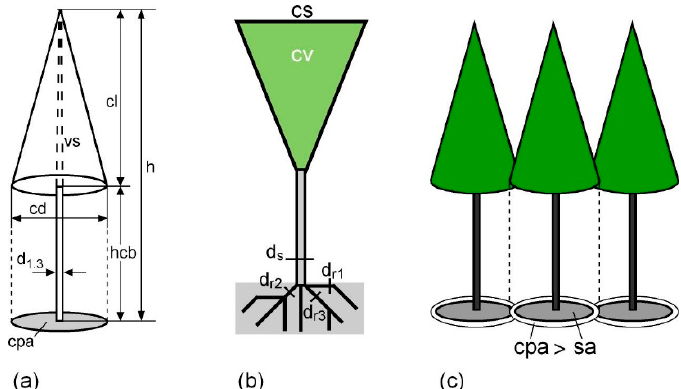
Figure 1. Dendrometrical tree characteristics. ( a ) Tree height, h, crown length, cl, height to crown base, hcb, crown diameter, cd, tree diameter at breast height, d1.3, and stem volume vs. variable cpa represents the crown projection area. ( b ) Crown volume, cv, crown surface area, cs, diameter of the stem, ds = d1.3, and diameter of the three tallest roots, dr1 … dr3. ( c ) Tree stand area equivalent to growing area, sa, and crown projection area, cpa. Particularly in densely packed stands, cpa is often larger than sa.